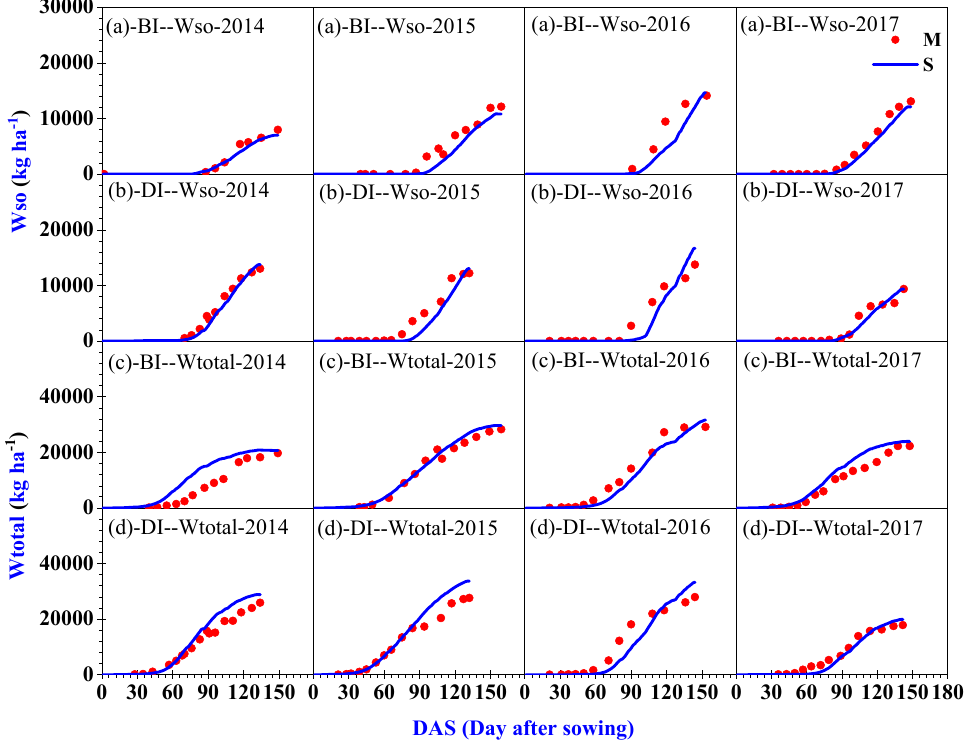
Figure 4. Comparison of measured values (M) and simulated values (S) of crop yield (Wso) and total dry matter (Wtotal) under border-irrigated treatment (BI) and drip-irrigated treatment (DI) during 2014–2017, respectively.